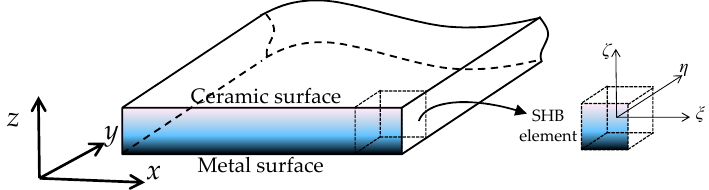
Figure 3. Schematic representation of the functionally graded thin plate.